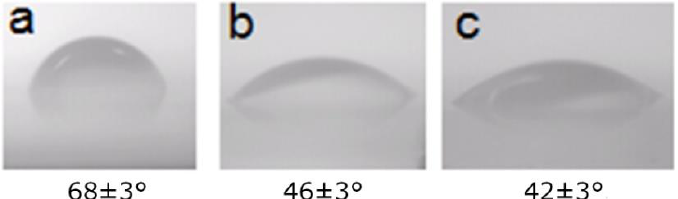
Figure 4. Changes in surface contact angle before and after poly(ethylene glycol) (PEG) passivation. The contact angle without passivation is 68° ±3°. The contact angle of the substrate with a 1mM concentration of PEG solution passivation is 46°±3°, and the contact angle of the substrate treated with the 10mM concentration of PEG is 42° ±3°. (a) Treatment without passivation. (b) Passivation with PEG–silane concentration of 1mM. (c) Passivation with PEG–silane concentration of 10mM.